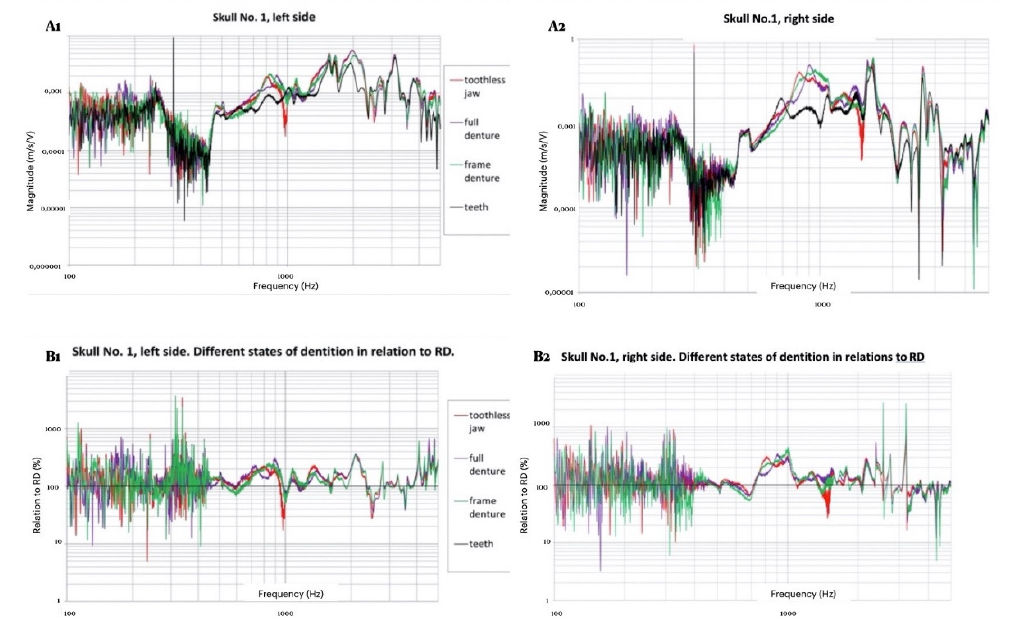
Figure 3. A1 and A2 : Frequency characteristics of transmittance (vibration velocity in the cochlear area in comparison to exciting the inductor on the jaw) in different states of dentition for left and right side. B1 and B2 : Differences between transmittances in different states of dentition concerning RD. Logarithmic scale for “X” and “Y” axis for left and right side.